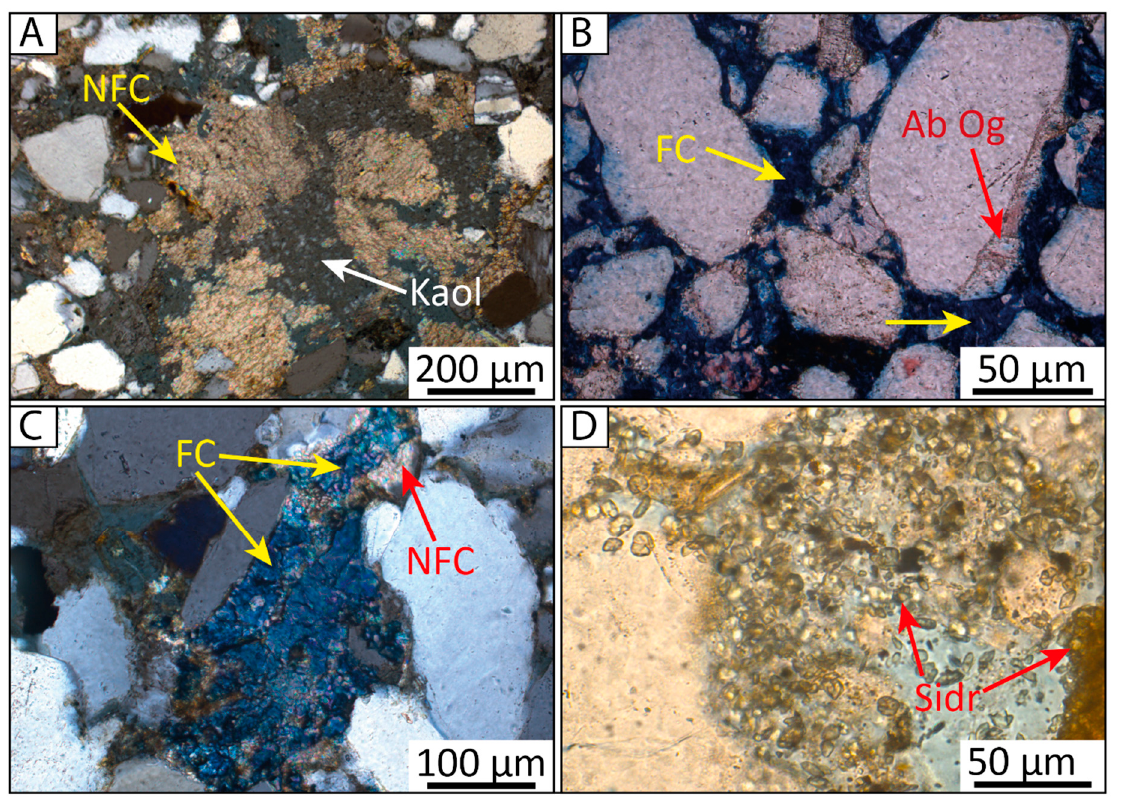
Figure 8. Thin-section photomicrographs showing the types and mode of occurrence of carbonate cements. ( A ) Non-ferroan calcite (NFC) filling intergranular porosity and engulfing kaolinite (Kaol). ( B ) Ferroan calcite (FC) and albite (Ab) overgrowth (Og) destroying intergranular porosity. ( C ) Ferroan calcite (FC) replacing dissolved non-ferroan calcite and filling intergranular pore space. ( D ) Siderite (Sidr) destroying intergranular porosity.